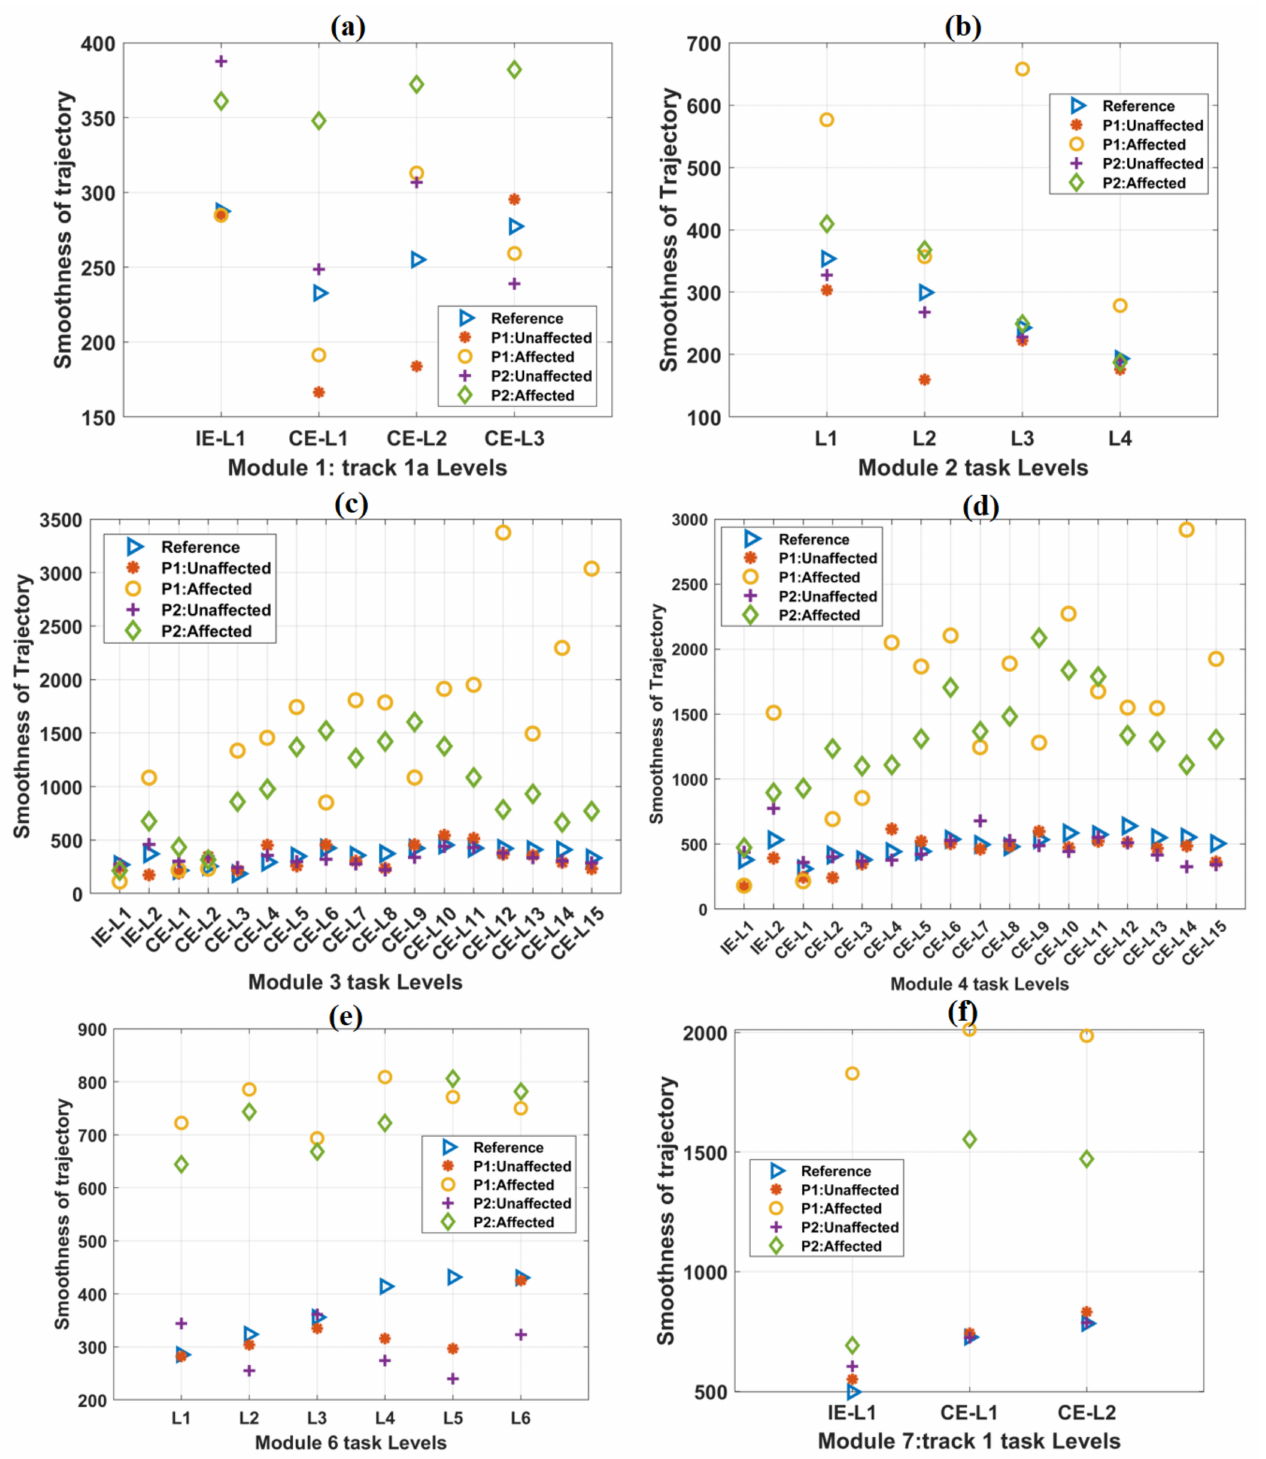
Figure 5. The variation of the Trajectory smoothness parameter with an increase in difficulty levels in ( a ) Module 1, ( b ) Module 2, ( c ) Module 3, ( d ) Module 4, ( e ) Module 6, and ( f ) Module 7 tasks. In each case, the scores of both the patients were plotted against the mean score of forty healthy subjects, which was taken as a reference. In most of the cases, trajectory smoothness values obtained from the affected hands of both the patients were relatively greater than these reference